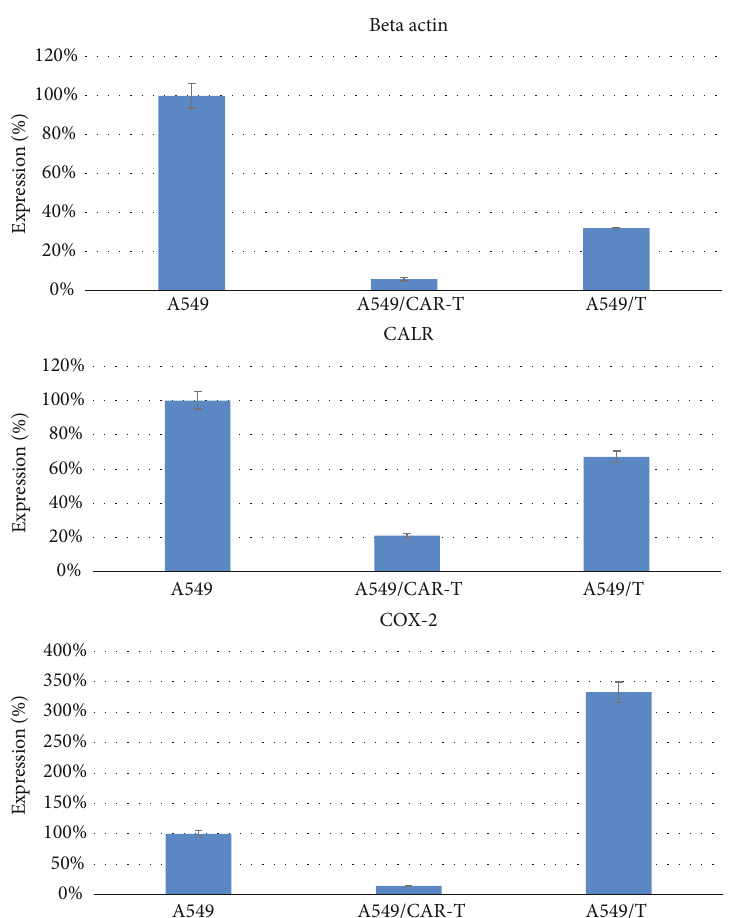
Figure 7: Comparison of expression of genes involved in metastasis in A549 cells before and after exposure to CAR-T cells and T